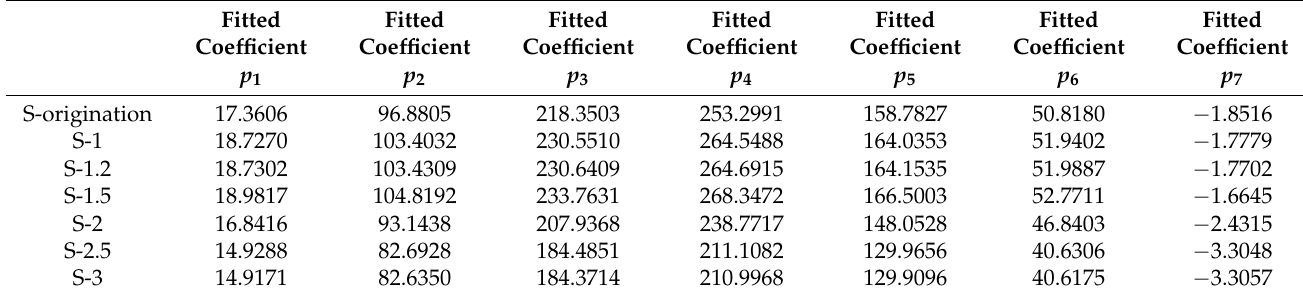
Table 8. The parameters of curve fitted function of